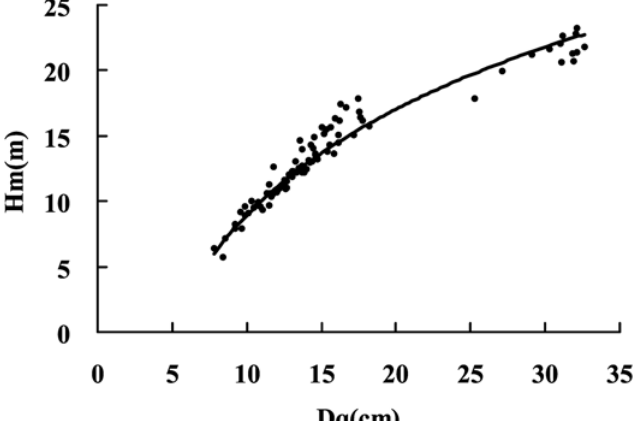
Fig 4. The scatter plot and logarithmic trend line for stand Dq and Hm. The solid line represents the trend line.